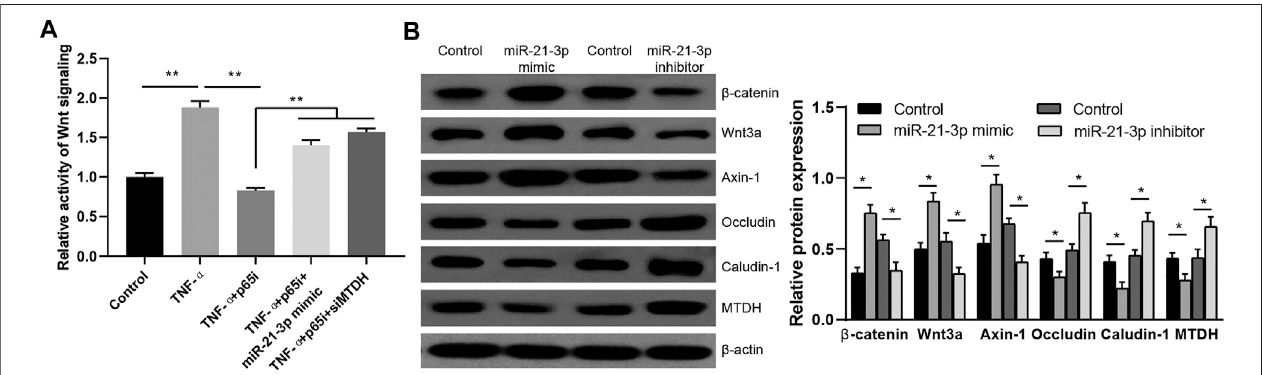
FIGURE 4 | miR-21-3p/MTDH/Wnt signaling pathway is involved in the TNF- α – induced Caco-2 cell model. (A) The activity of Wnt signaling was evaluated by the Wnt reporter assay. The introduction of miR-21-3p mimic or downregulation of MTDH could reverse the inhibition by parthenolide. (B) The protein expression was detected in Caco-2 cells transfected with the miR-21-3p mimic or inhibitor. Wnt activation was evaluated with antibodies detecting the indicated Wnt pathway targets. * p < 0.05, ** p <